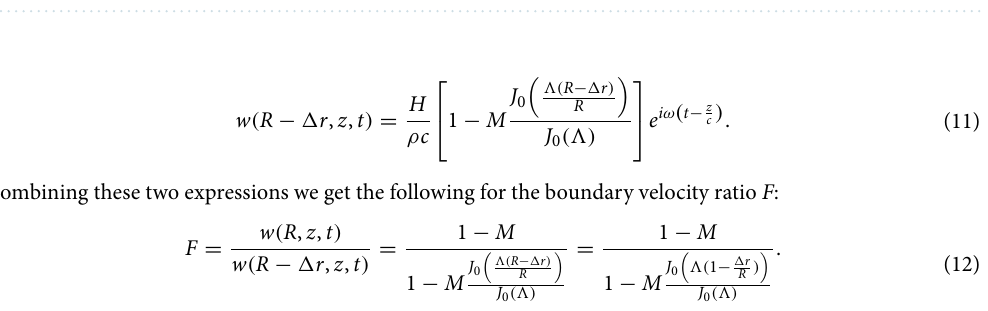
Figure 2. Distribution of boundary velocity ratio for a range of physiologically relevant values of (cid:31) E (0–10%) and Womersley number (0–10) in vessels with a radius of 1